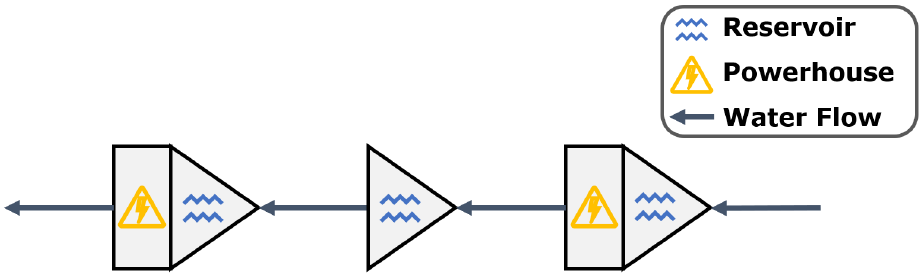
Figure 1. An example of a hydropower system with three reservoirs and two powerhouses. The arrow shows the direction of water movement, which can be held and released when interacting with a reservoir (triangle) and a powerhouse